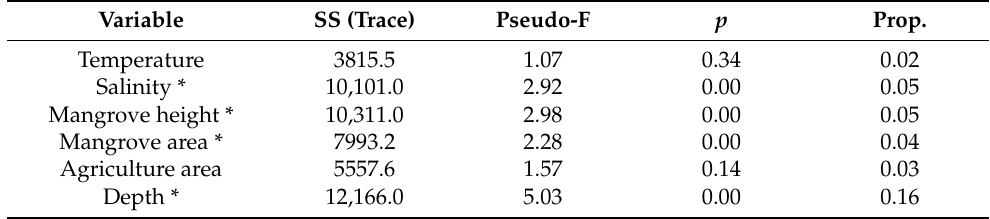
Table 2. Marginal test of the distance-based linear model (DISTLM) showing the relationships of the different environmental factors with the fish assemblages. * indicates statistically significant results. Variable SS (Trace) Pseudo-F p Prop. Temperature